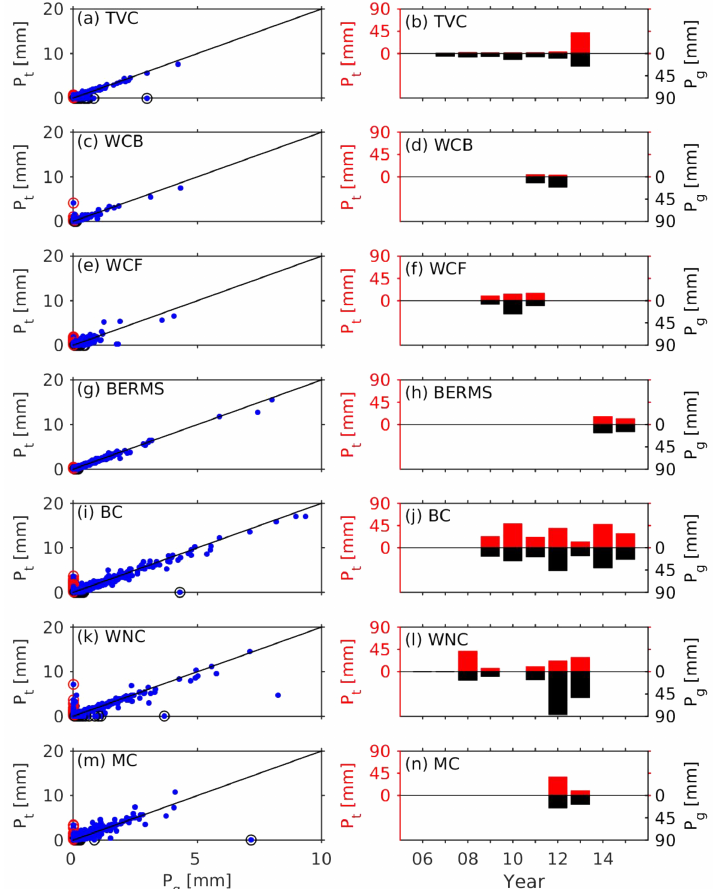
Figure 4. Comparison of rainfall rates from TBRG ( P t ) and Geonor-SA ( P g ) measurements at the sites (TVB, WCB, WCF, BERMS, BC, WNC, and MC). The left panel compares the rainfall rates at timescales of 30min over the whole period. Cases where only one of the gauges did measure precipitation are extra marked: red circles for P t > 0 and P g = 0, and black circles for P t = 0 and P g > 0. The right panel shows the yearly total amounts of “missing” precipitation at the two